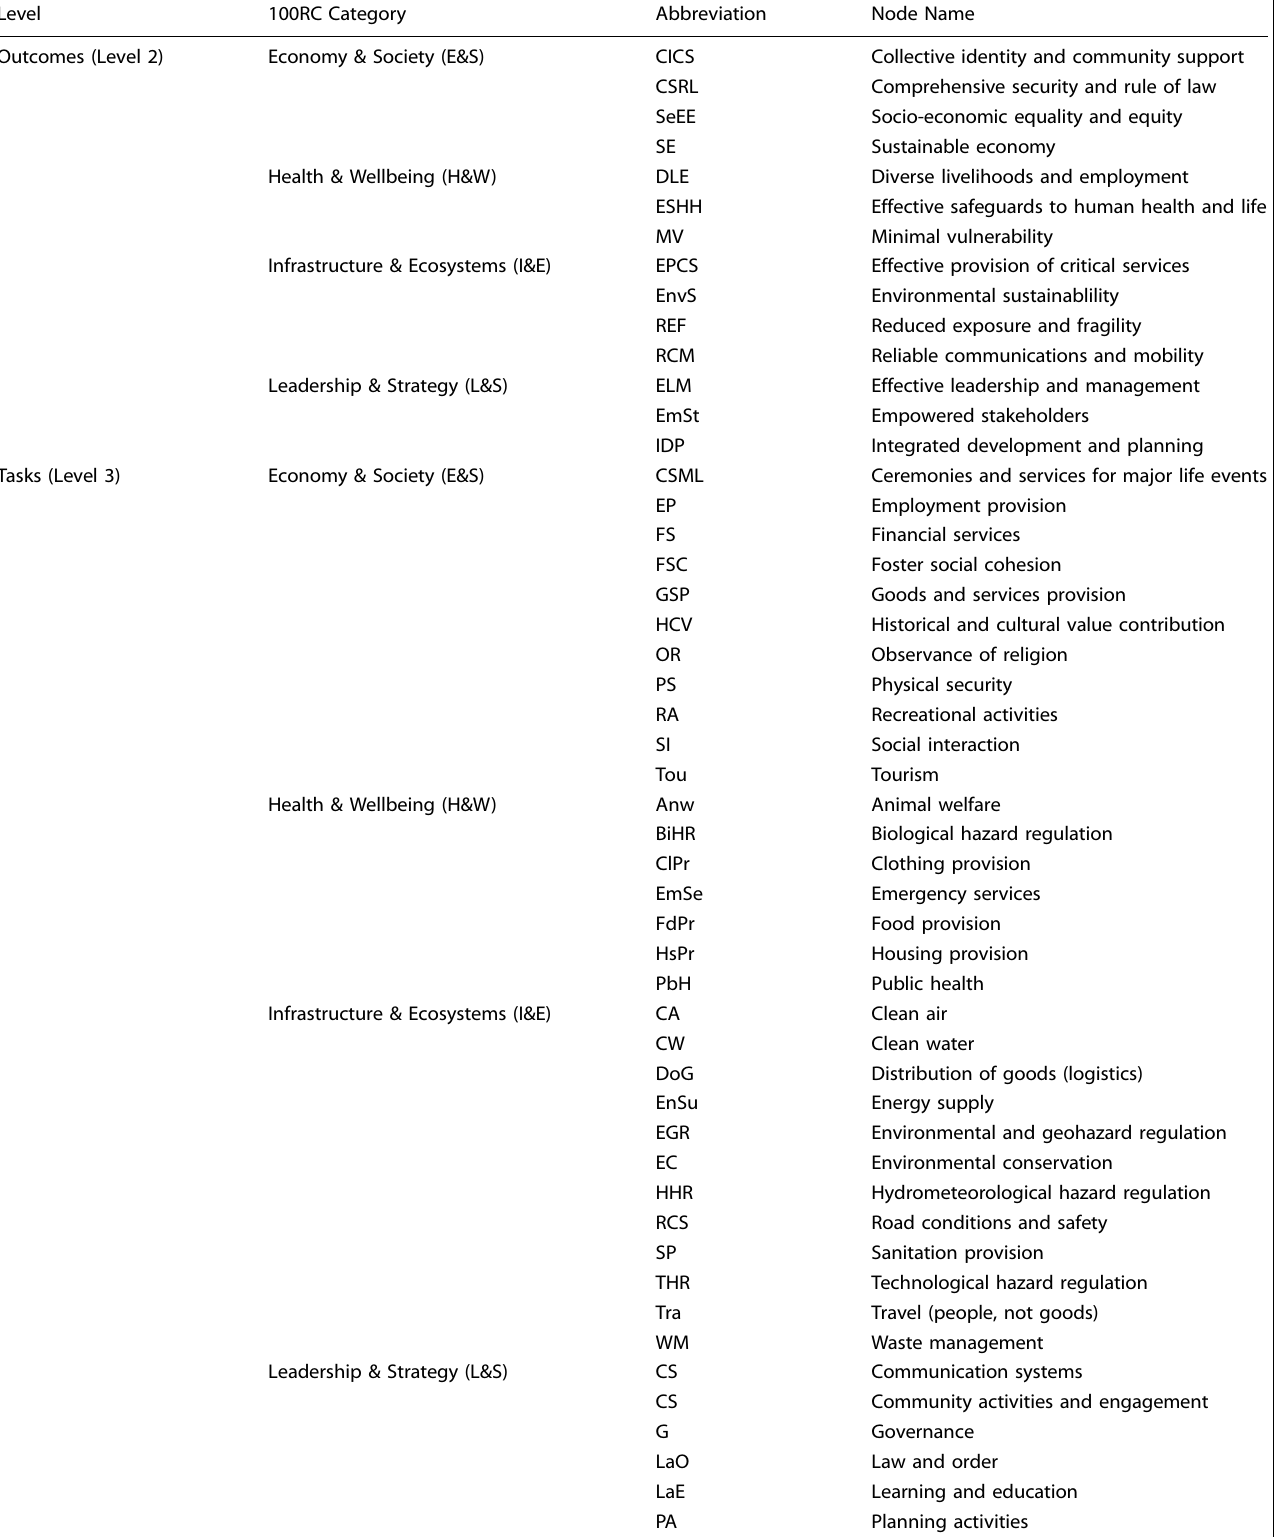
Table 8. Outcomes and Tasks mapped to 100RC categories with